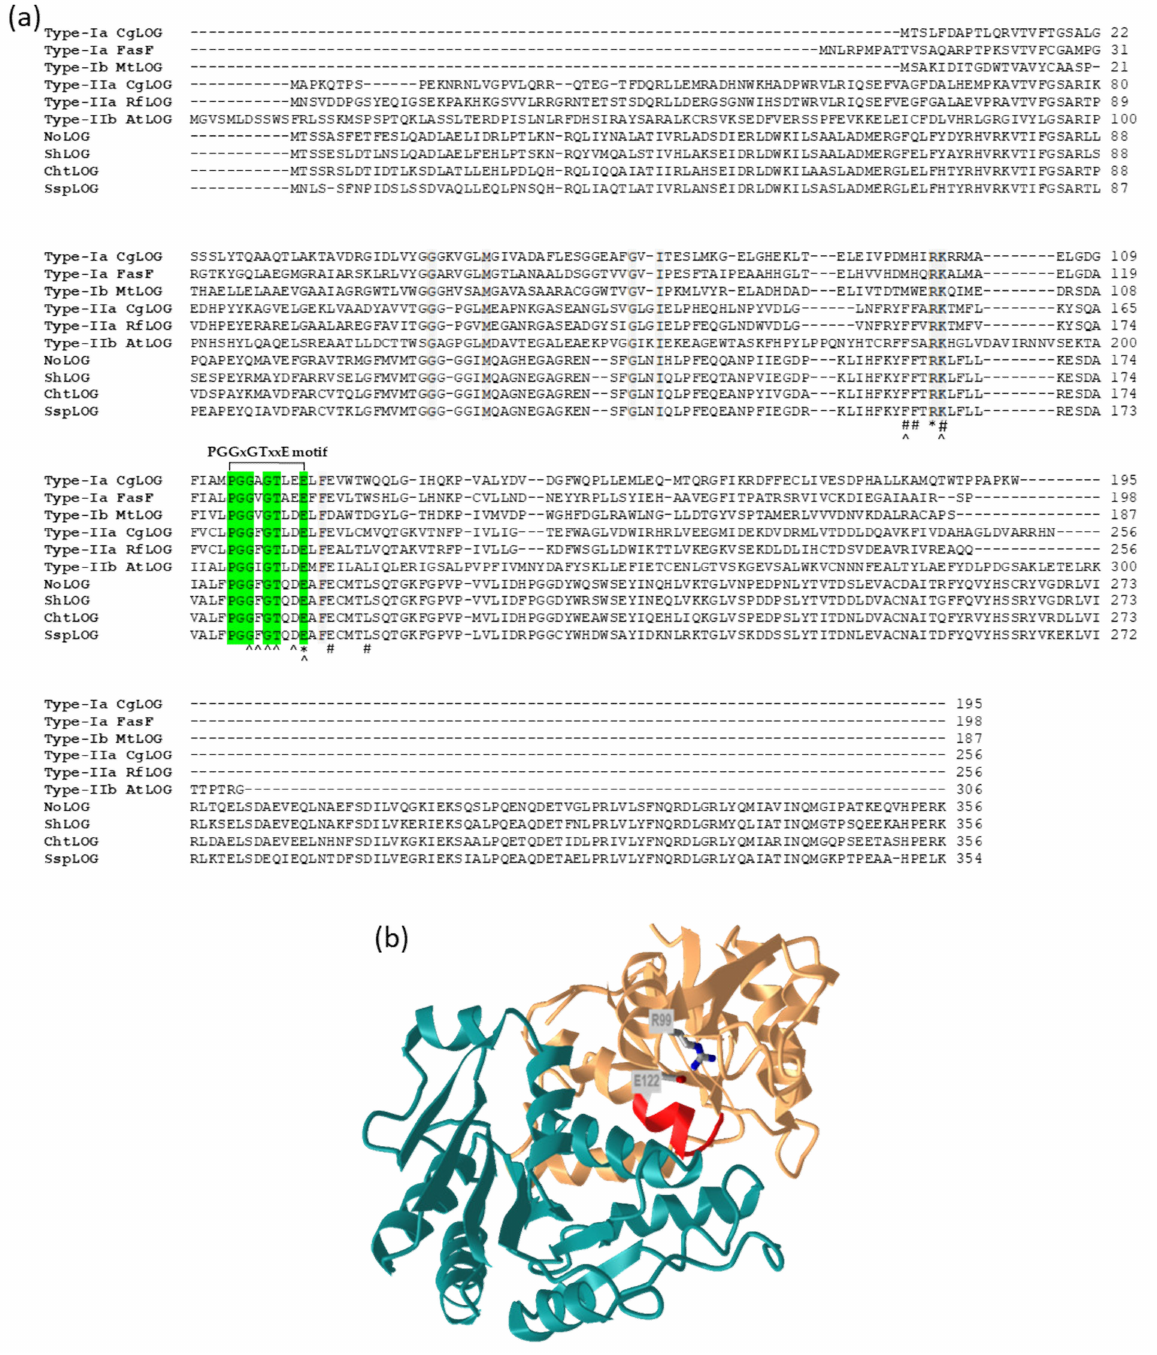
Figure 4. Amino acid composition and structure of LOG. ( a ) Amino acid sequence alignment of different LOG proteins. Protein sequences were aligned using the ClustalW interface in BioEdit 7.2.5 [77]. Conserved PDDxGTxxE motif is highlighted by green background and other fully conserved amino acid residues in grey. Residues involved in enzyme catalysis (*), AMP binding (ˆ), and prenyl group binding (#) are indicated below the sequence [68]. Numbers on the right indicate an amino acid position in the respective protein. CgLOG, FasF, MtLOG, RfLOG, AtLOG, NoLOG, ShLOG, ChtLOG, and SspLOG are the abbreviations for LOGs from Corynebacterium glutamicum ATCC 13032, Rhodococcus fascians D188 (located on the virulence plasmid), Mycobacterium tuberculosis H37Rv, R. fascians D188 (located on chromosome), Arabidopsis thaliana , Nostoc sp. PCC 7120, Scytonema hofmanni PCC 7110, Chroococcidiopsis thermalis PCC 7203, and Synechocystis sp. PCC 7509, respectively. ( b ) Dimeric structure of a type I CgLOG showing the position of fully conserved catalytic residues Arg and Glu (R99 and E122, respectively) and PGGxGTxxE motif (in red) in one of the monomers. The two monomers are shown in gold and green, respectively. The image was drawn by iCn3D structure viewer [50] using PDB coordinates 5ITS